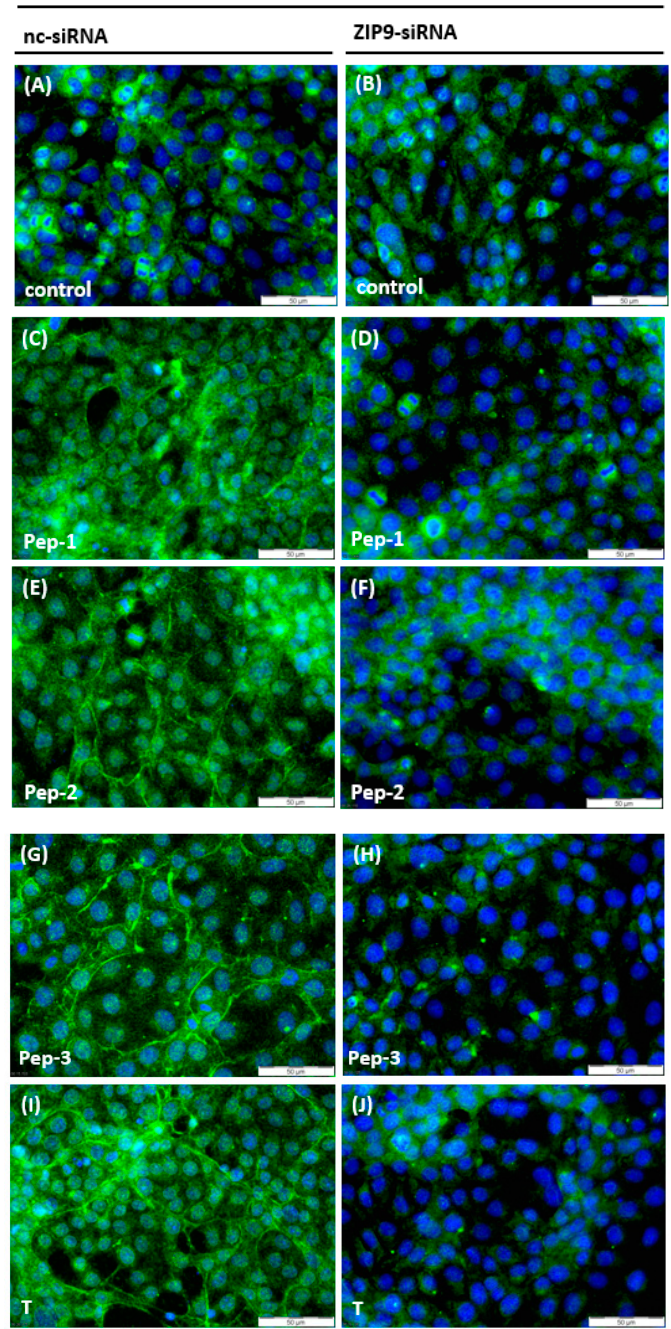
Figure 9. Detection of Claudin-5 in Sertoli cells by immunofluorescence. Claudin-5 is represented by green fluorescence, nuclei are stained blue. ( A ) Detection of basal levels of Claudin-5 in 93RS2 cells treated with nc-siRNA, without any further stimulation. ( B ) Bassal levels of Claudin-5 in cells treated with ZIP9-siRNA, without any further treatment. ( C , E , G , I ) Cells treated with nc-siRNA and stimulated with peptides (10 µM) or testosterone (10 nM) for 24 h. Claudin-5 expression is increased in the cytoplasm and visible in the membranes. Cells shown in ( D , F , H , J ) were treated with ZIP9-siRNA before exposed to peptides or testosterone. Only basal levels of Claudin-5 are detected.